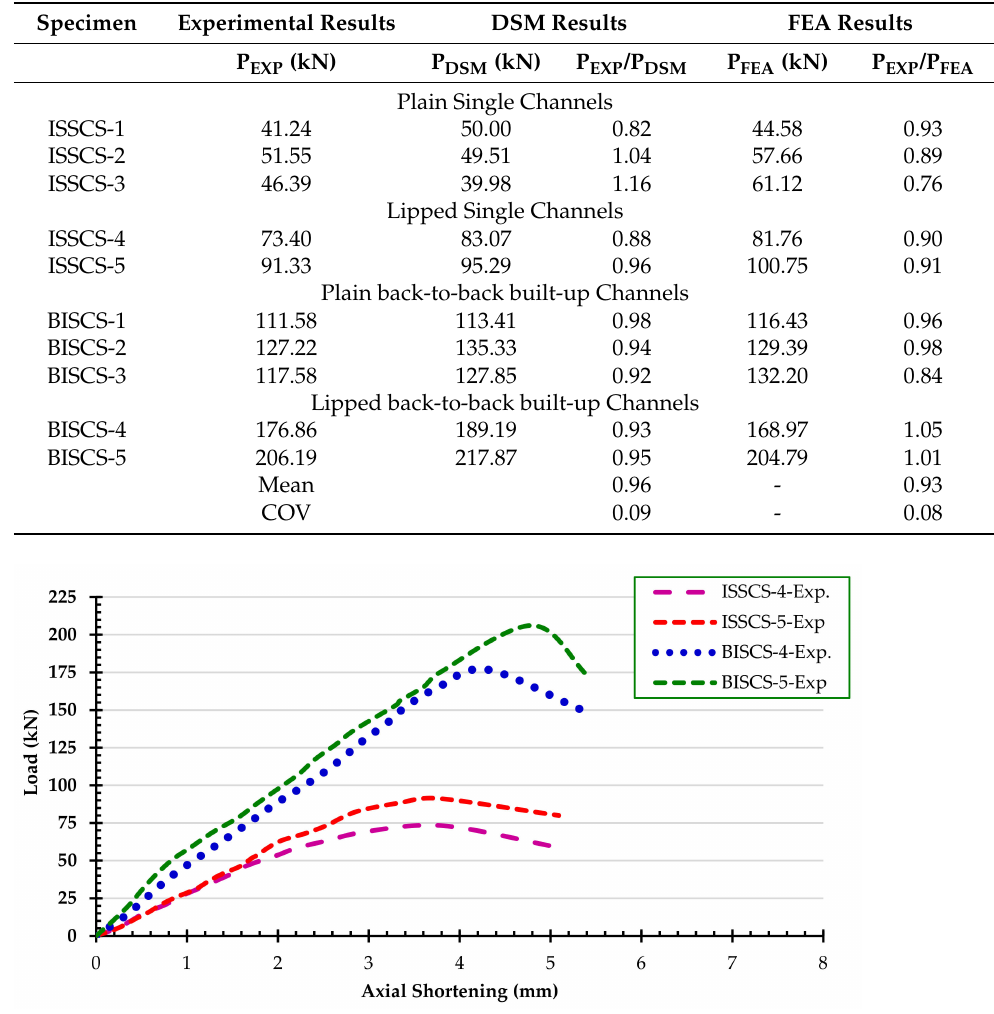
Table 2. Relationship between the tests and FEA results for ISSCS and BISCS.